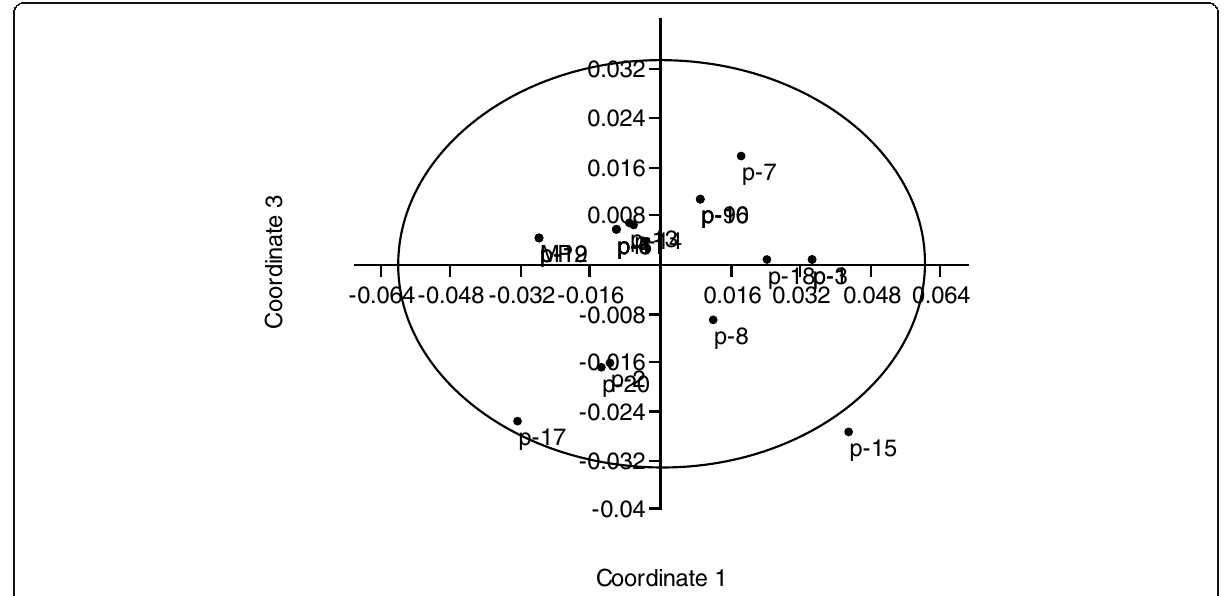
Fig. 4 The principal coordinate analysis (PCA) of SSR data from the micropropagated plants and mother